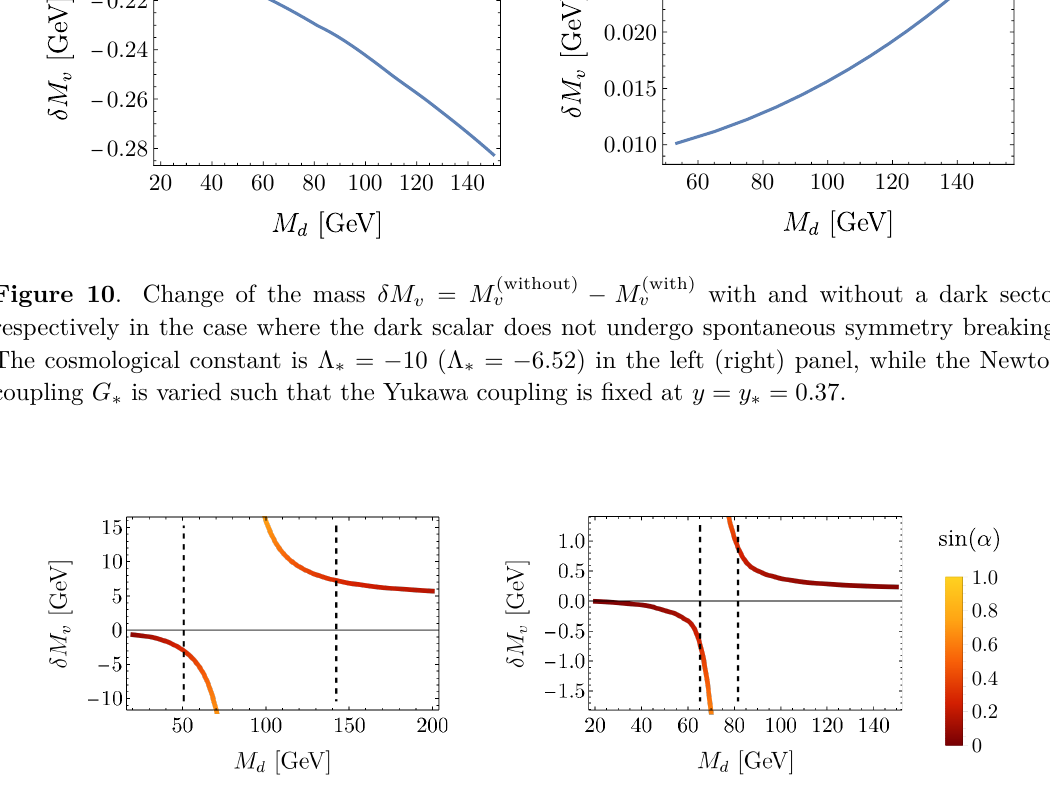
Figure 11 . Change of the mass δM v = M ( without ) v − M ( with ) v with and without a dark sector in the case where the dark scalar does undergo spontaneous symmetry breaking. The cosmological constant is set to Λ = − 10 (left) and Λ = − 6 . 52 (right), while the Newton constant is adjusted ∗ ∗ so that the visible Yukawa coupling remains fixed at y = y = 0 . 37 , i.e., we perform a fixed-Yukawa ∗ scan. The mixing angle is colour-coded; the dashed line demarcates where sin( α ) < 0 . 3 , which is approximately the experimental constraint on the mixing of the SM